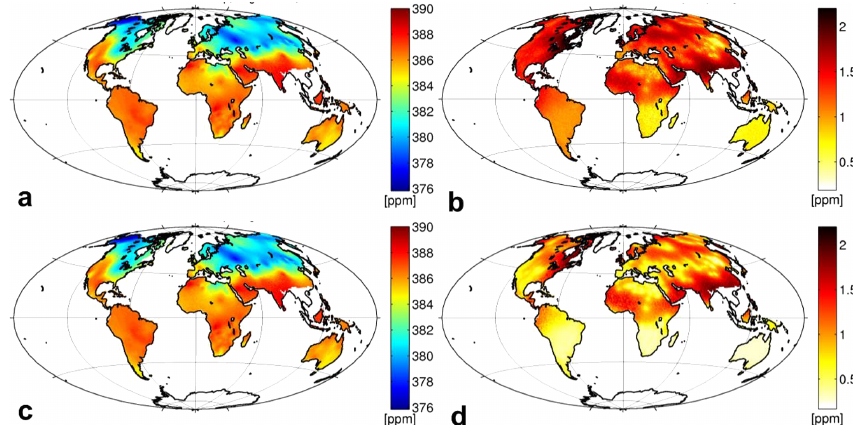
Figure 2. XCO 2 Level 3 maps (a, c) and associated uncertainties (b, d) based on ACOS 3.4 release-3 retrievals (“estimates”) for 2–7 August 2009 at (a, b) native resolution and (c, d) 1 ◦ × 1 ◦ resolution, obtained using the proposed mapping approach.